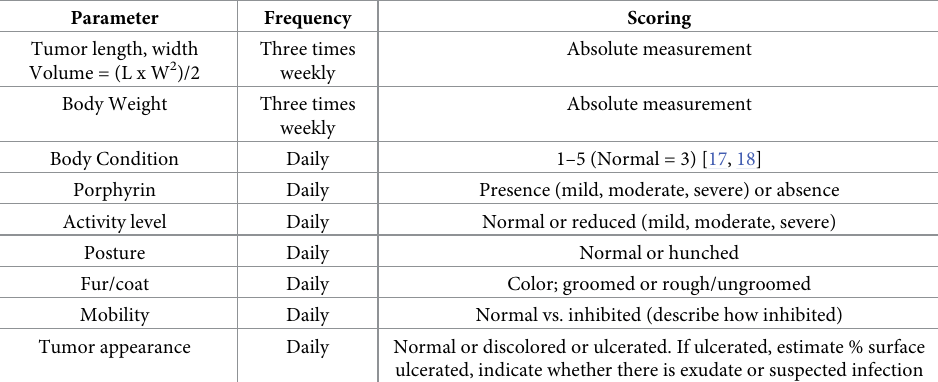
Parameter Frequency Scoring Tumor length, width Three times Absolute measurement Volume = (L x W 2 )/2 weekly Body Weight Three times Absolute measurement weekly Body Condition Daily 1–5 (Normal = 3) [17, 18] Porphyrin Daily Presence (mild, moderate, severe) or absence Activity level Daily Normal or reduced (mild, moderate, severe) Posture Daily Normal or hunched Fur/coat Daily Color; groomed or rough/ungroomed Mobility Daily Normal vs. inhibited (describe how inhibited) Tumor appearance Daily Normal or discolored or ulcerated. If ulcerated, estimate % surface ulcerated, indicate whether there is exudate or suspected